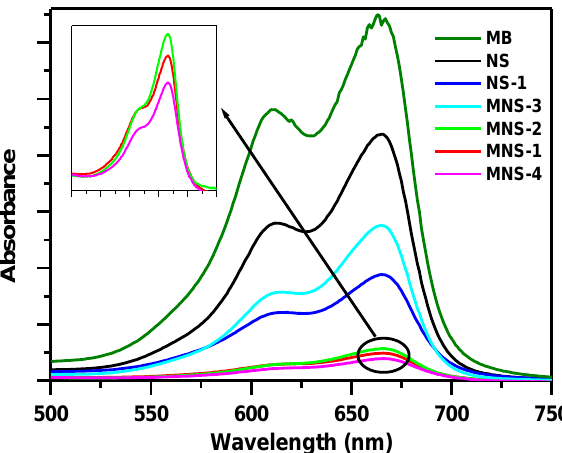
Figure 1. UV spectra of methylene blue (MB) solutions (20 ppm) before and after contact with nigella sativa (NS) and its modified derivatives.